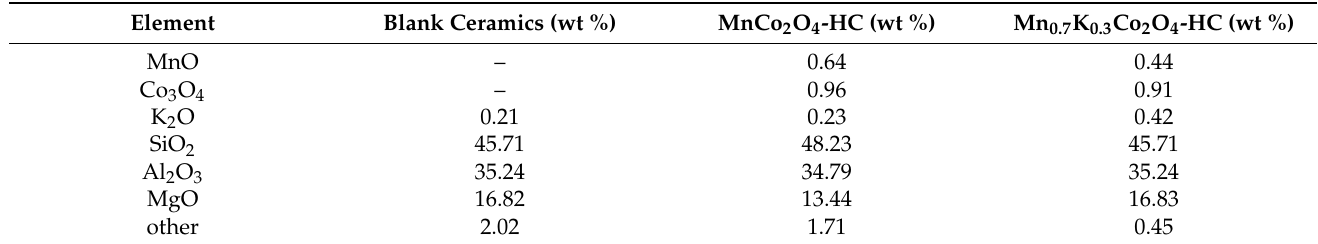
Table 2. XRF results of oxide content on monolith catalysts and blank ceramics.